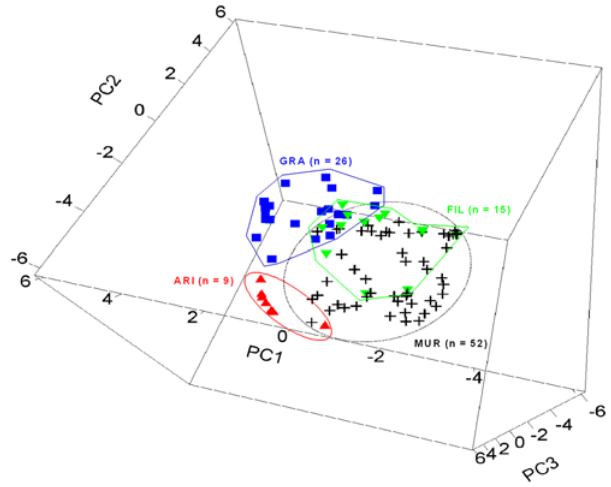
Figure 3. Three-dimensional representation of the variation in aromatic plant species composition of nests between study plots. Axes are those resulting from a PCA on the log-transformed relative abundances of the 15 aromatic plant species identified in nests (see Methods). Points representing nests from the ‘MUR’ site are located in the back of the figure, whereas points representing nests from the ‘FIL’ plot are in the front of it.